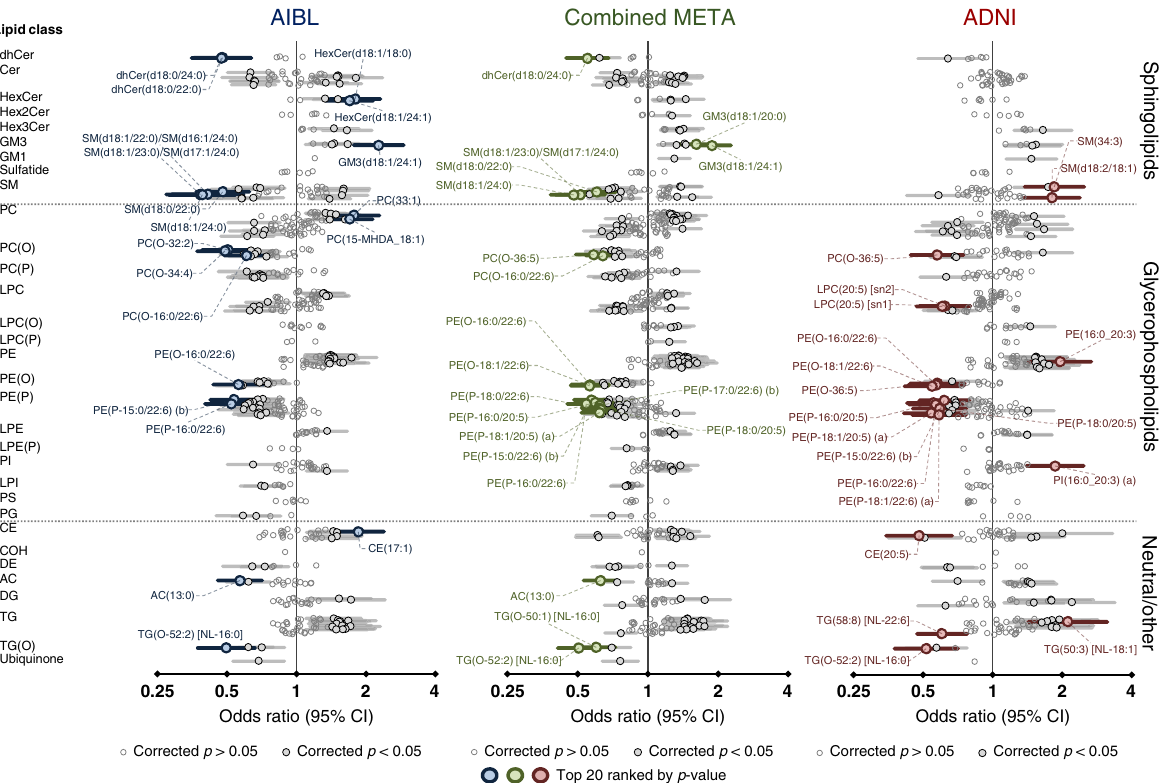
Fig. 3 Associations of individual lipid species with prevalent Alzheimer ’ s disease. Forest plot outlining the logistic regression results of individual species, between controls and prevalent AD in both the AIBL (blue n = 268 cases, 696 controls) and ADNI (red, n = 178 cases, 210 controls) cohorts with the combined meta-analysis in the middle (green). P value was corrected for multiple comparison using approach by Benjamini and Hochberg. Covariates include age, sex, BMI, total cholesterol, HDL-C, triglycerides, number of APOE4 alleles, statin use and omega-3 supplementation. Additional covariates for AIBL include site of blood collection and time point while ADNI includes fasting status. Open circles, not signi fi cant; closed dark circles, signi fi cant after FDR correction; coloured circles, top 20 associations ranked by p